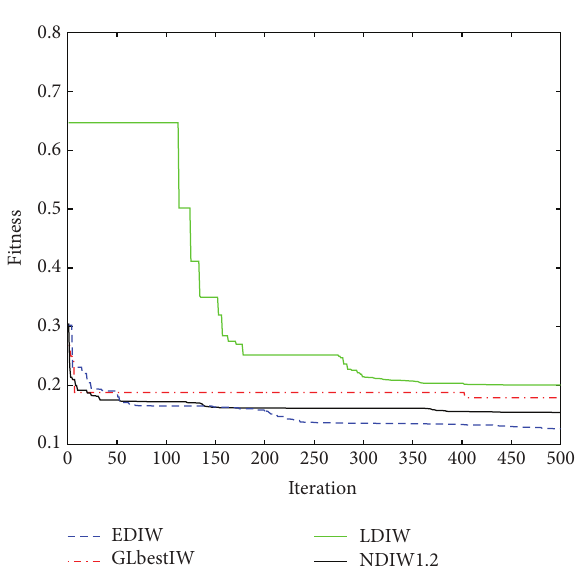
Figure 4: The best global fitness value for the AQI of Xi’an. Blue short dash line shows the best global fitness value by the improved EDIW-PSO-RBF model; red dashdotted line shows the best global fitness value by the GLbestIW-PSO-RBF model; green solid line shows the best global fitness value by the LDIW-PSO-RBF model; black solid line shows the best global fitness value by the NDIW- PSO-RBF